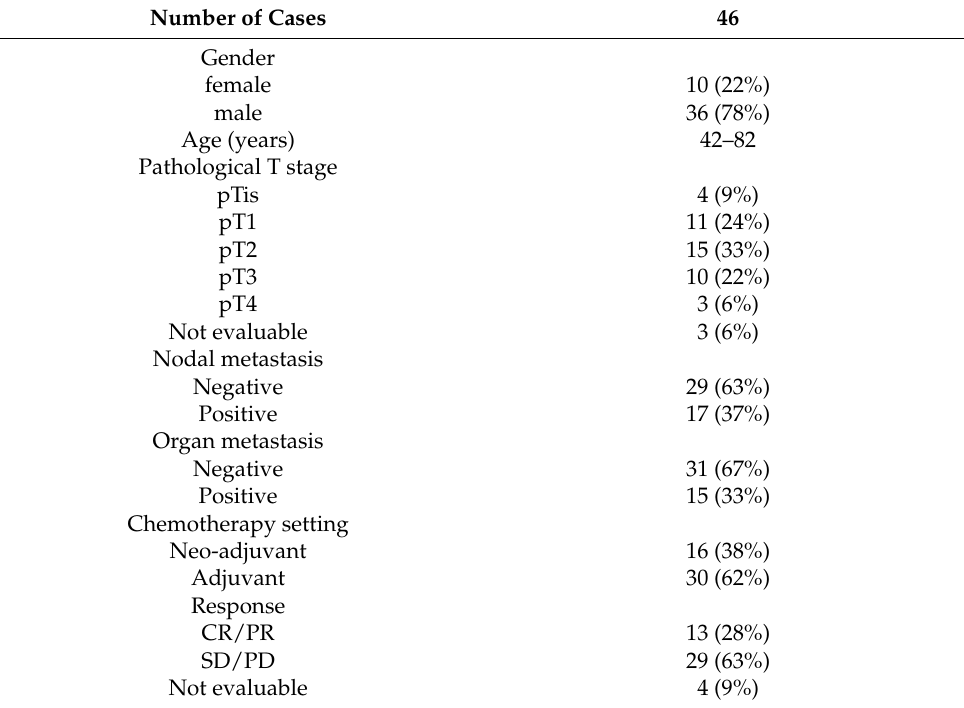
Table 7. Clinicopathologic characteristics of 46 bladder cancer patients who were treated with cisplatin based chemotherapy.